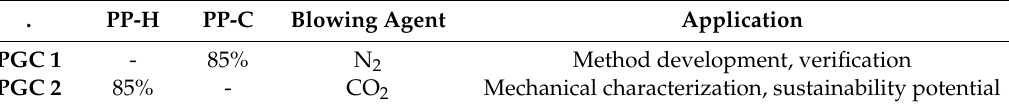
Table 1. Materials used in this work and their